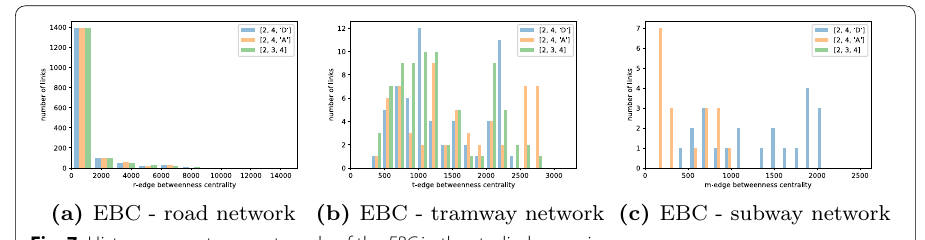
Fig. 7 Histogram per transport mode of the EBC in the studied